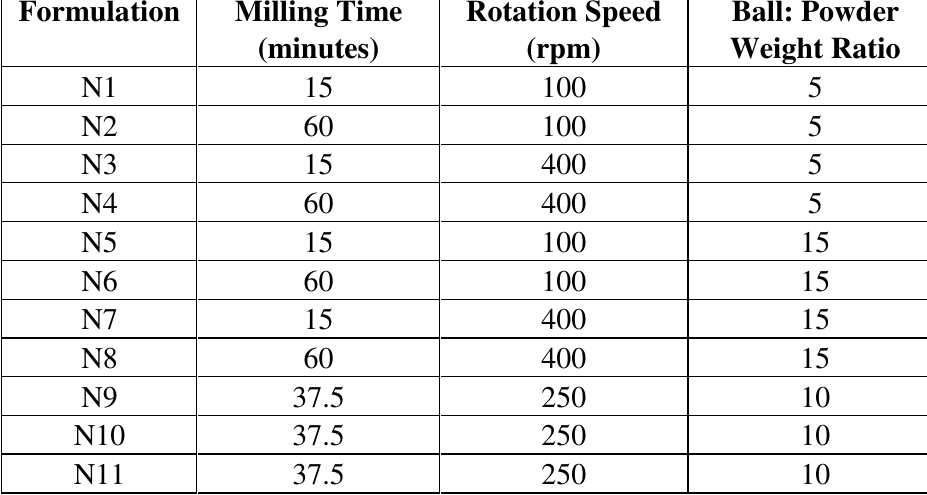
Table 1. Ball milling conditions of the various